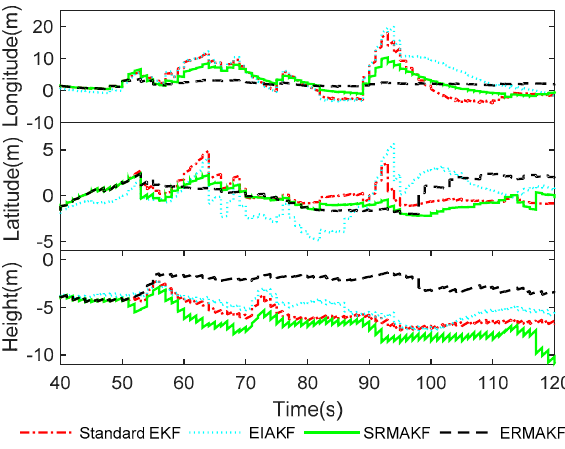
Figure 4. Position errors comparison.